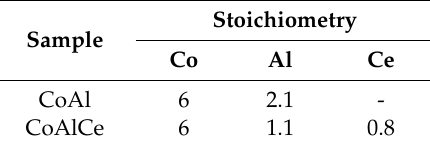
Table 2. Elemental analysis of CoAl, CoAlCe determined by ICP.